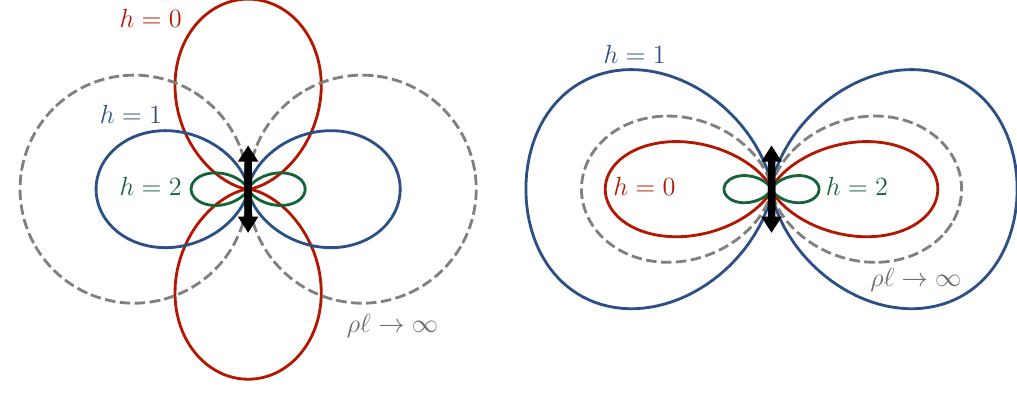
Figure 4 . Angular distribution of helicity h radiation (not to scale) from a particle in nonrelativistic sinusoidal motion with amplitude ‘ and ρ‘ (cid:28) 1 , for a scalar-like (left) or vector-like (right) current. The dashed curve shows the total power emission in all helicities in the deep infrared limit ρ‘ → ∞ .